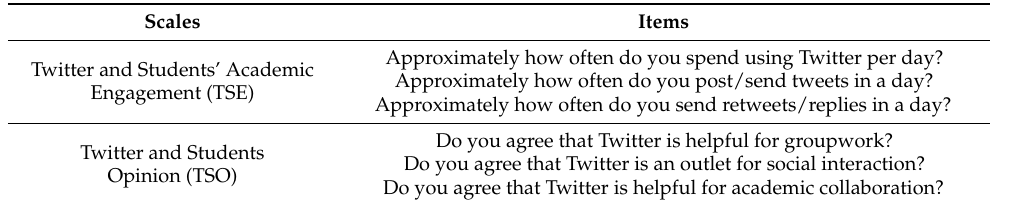
Table 3. Scales and items of this